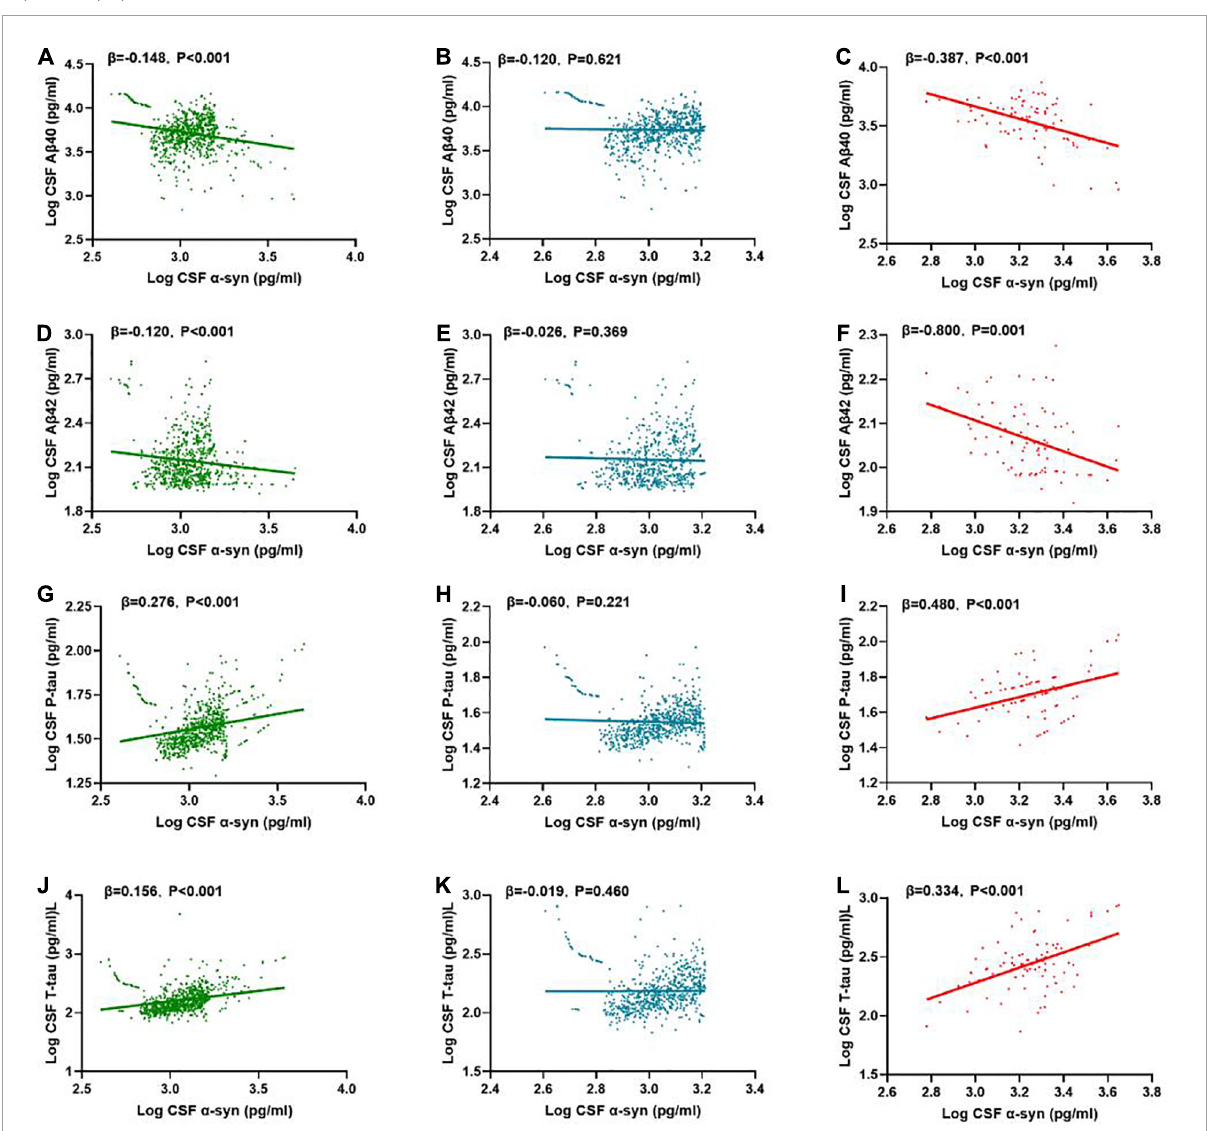
FIGURE3 Associations of CSF α -syn and CSF core biomarkers. Scatter plots represent the associations of CSF α -syn with CSF core biomarkers: A β 40, A β 42, T-tau, P-tau in the different groups [whole cohort (A,D,G,J) , POD (C,F,I,L) , non-POD (B,E,H,K) ]. The normalized regression coefficients ( β ) and P -values computed by multiple linear regression after adjustment for age, gender, educational level were shown. CSF, cerebrospinal fluid; α -syn, α -synuclein; A β 40, amyloid- β 40; A β 42, amyloid- β 42; T-tau, total Tau; P-tau, phosphorylated